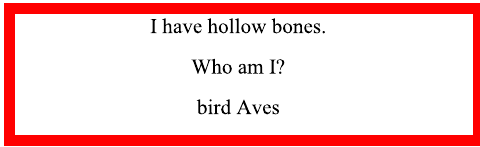
Fig. 3. Sample of the characteristic of classes of vertebrate: bird Aves